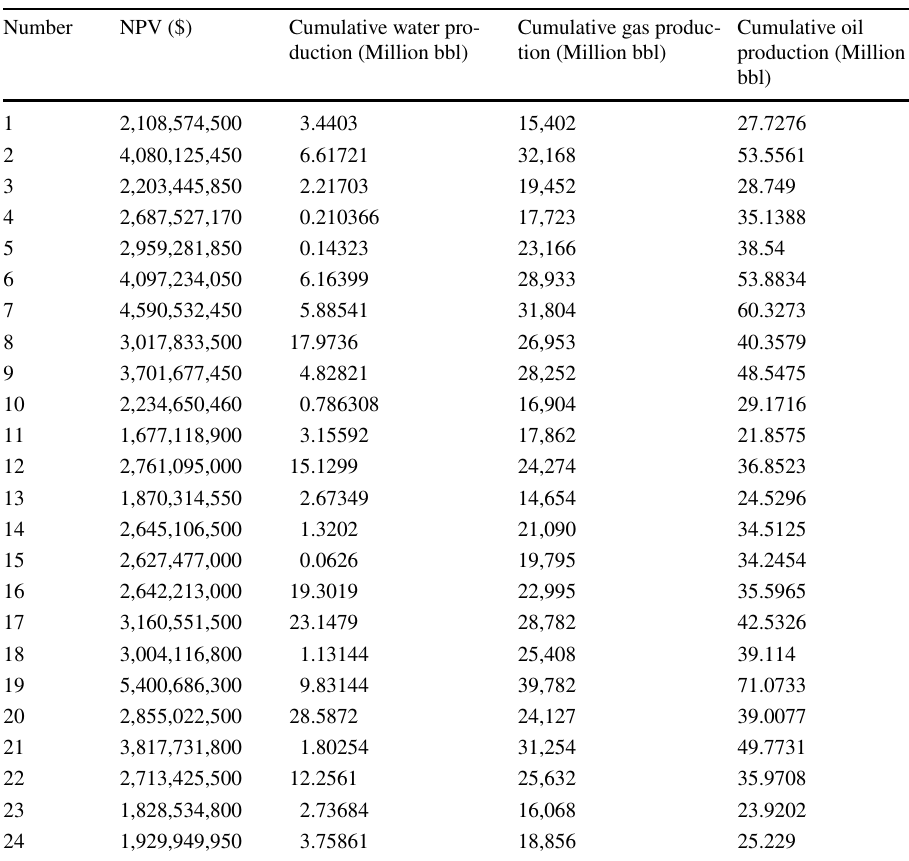
Table 9 The values of target functions for the 24 stages of the Plackett–Burman experimental design (derived from the implementation of the integrated model at each step)